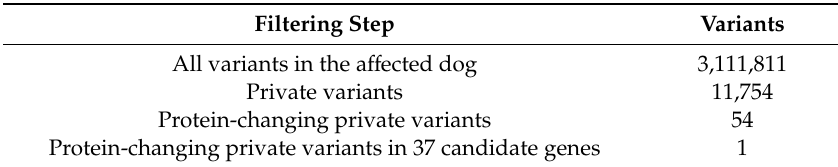
Table 2. Results of variant filtering in the a ff ected Australian Shepherd dog against 73 control genomes. Only homozygous variants are